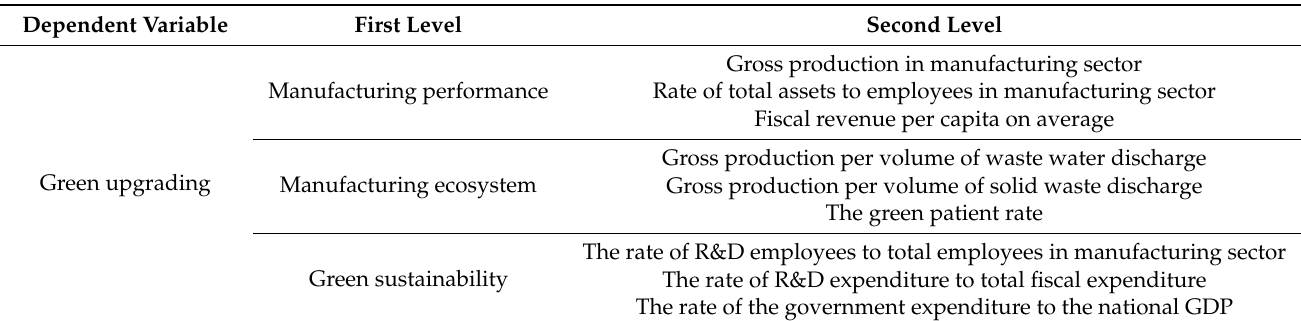
Table 1. The hierarchical factors of manufacturing green upgrading. Dependent Variable First Level Second Level Gross production in manufacturing sector Manufacturing performance Rate of total assets to employees in manufacturing sector Fiscal revenue per capita on average Gross production per volume of waste water discharge Green upgrading Manufacturing ecosystem Gross production per volume of solid waste discharge The green patient rate The rate of R&D employees to total employees in manufacturing sector Green sustainability The rate of R&D expenditure to total fiscal expenditure The rate of the government expenditure to the national